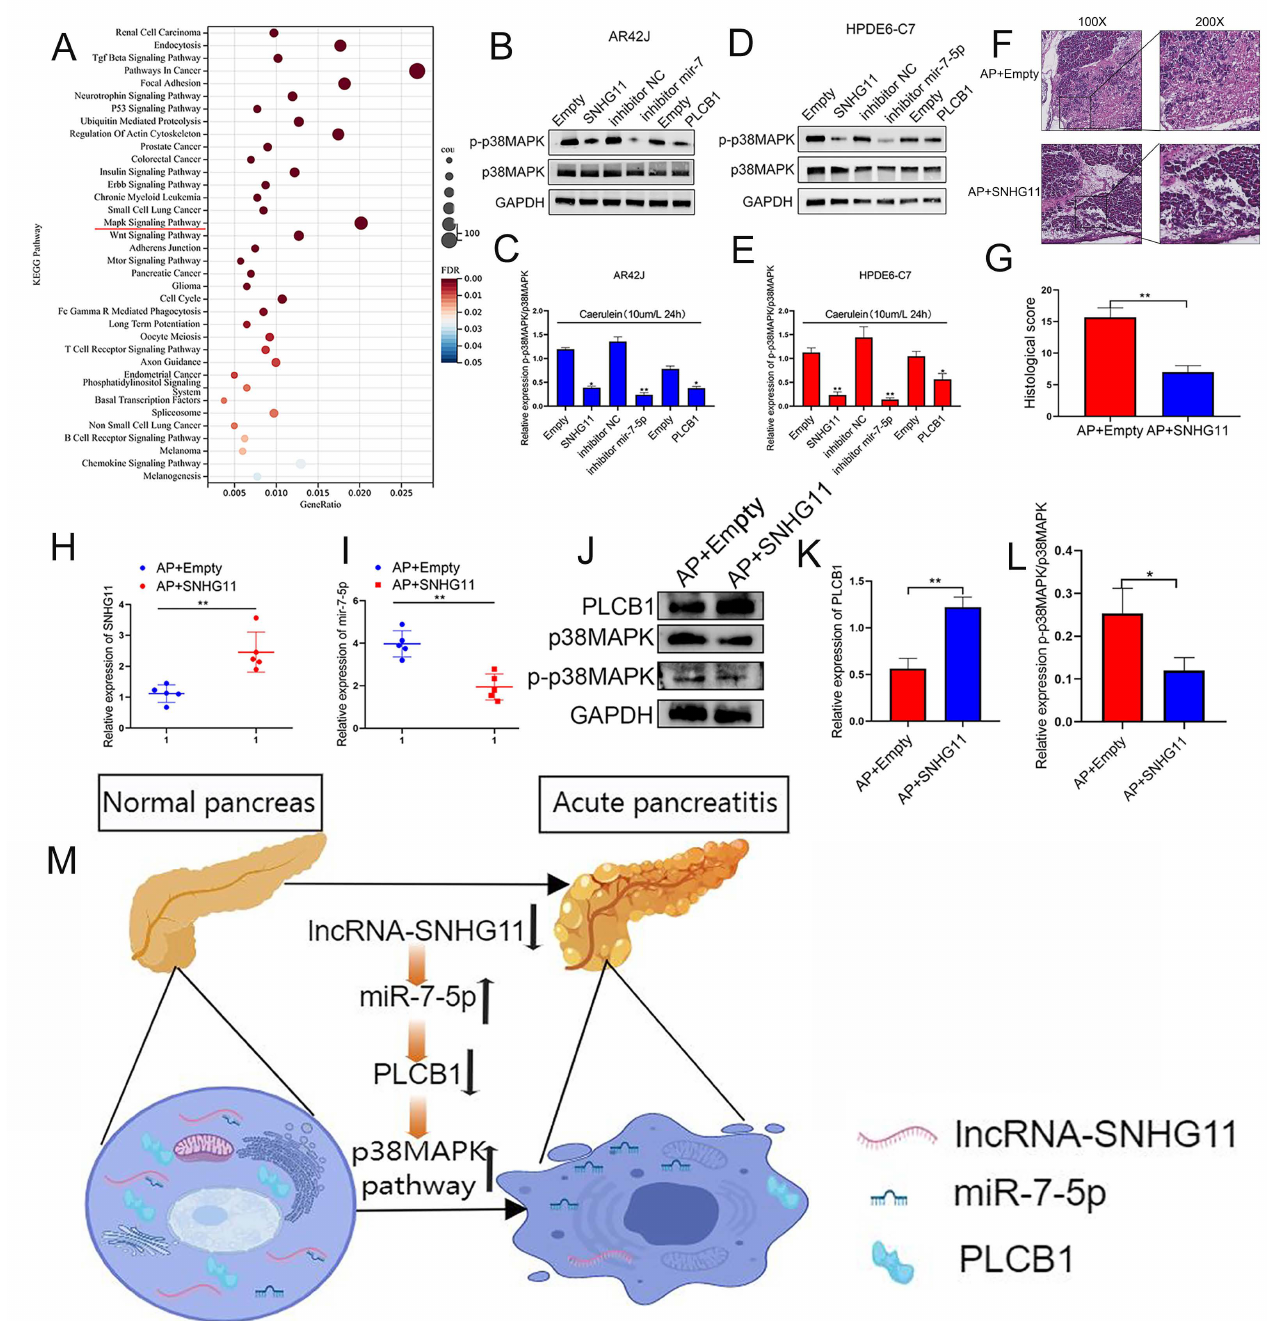
Figure 7. SNHG11/miR-7-5p/PLCB1 plays an inhibitory role in pancreatitis by inhibiting the p38MAPK signaling pathway. ( A ) The bubble chart shows a significant enrichment of the KEGG pathway by PLCB1-related ceRNA genes. ( B – E ) In AR42J and HPDE6-C7 cells, the high expression of SNHG11 and PLCB1 could inhibit the expression of p-P38MAPK and the activation of the MAPK signaling pathway, while the low expression of MiR-7-5p showed the same effect. ( F , G ) The effect of SNHG11 on rat models of AP was confirmed by HE staining, and representative images have been shown. ( H , I ) The expression of SNHG11 and miR-7-5p was assessed in different rat tissues(AP+empty vs. AP+SNHG11). ( J – L ) The expression of PLCB1 and p -P38MAPK was verified in different rat tissues (AP+empty vs. AP+SNHG11). The data are presented as means ± SDs, n = 3 each group, * p < 0.05; ** p < 0.01; between the indicated groups. ( M ) Schematic diagram of SNHG11/MiR-7-5p/PLCB1 affecting pancreatitis through activation of p38MAPK